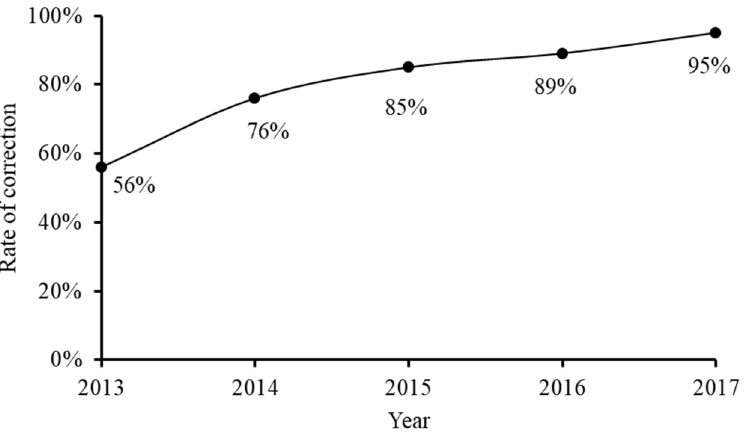
Figure 6. Trend of correctly solving first-order ODEs by engineering students in 2013–2017.